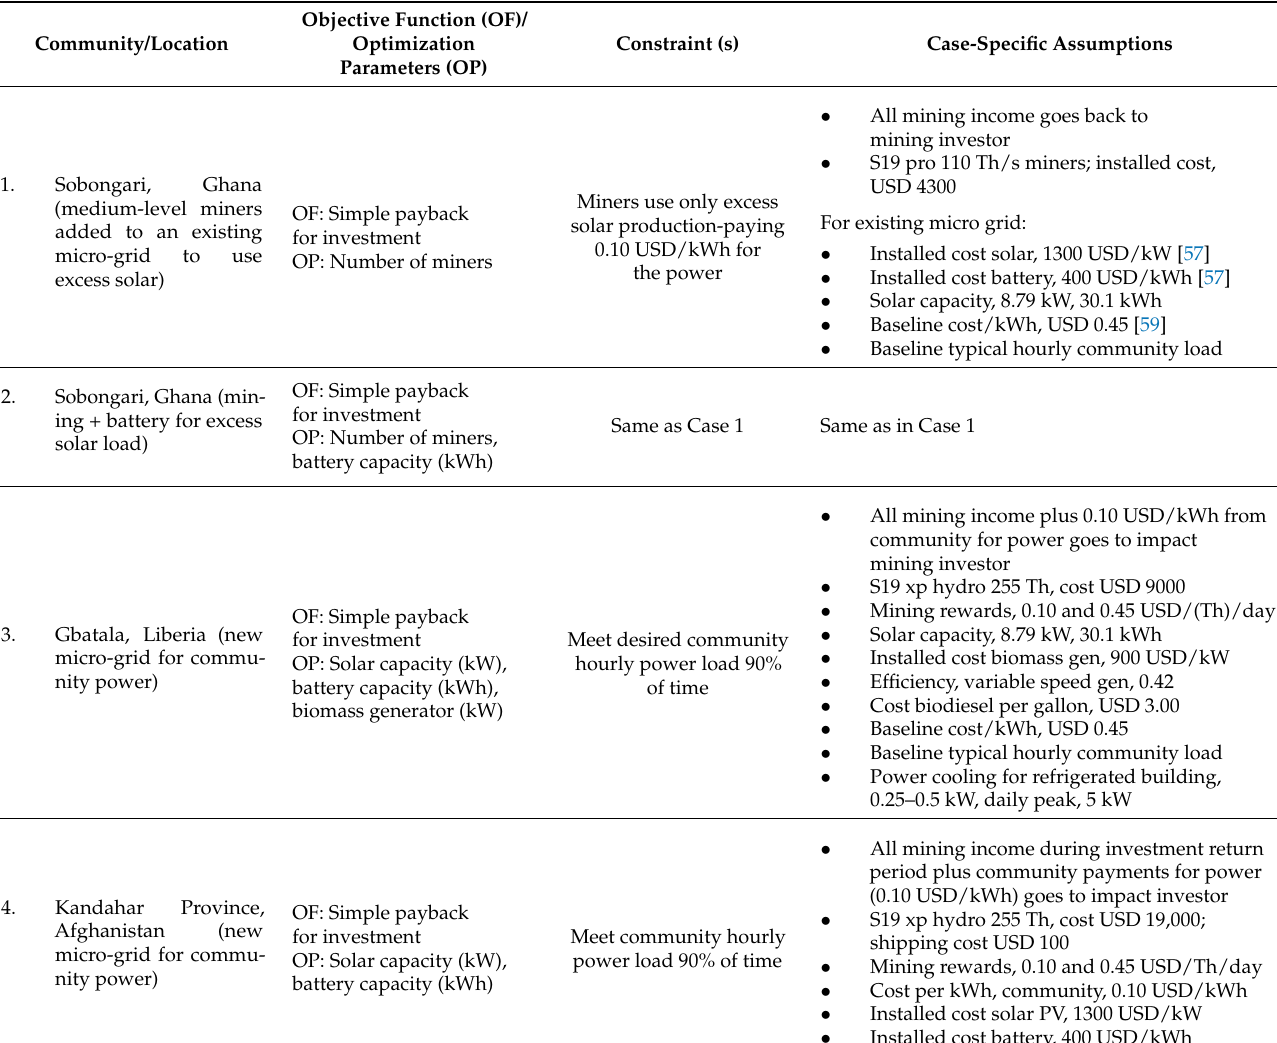
Table 2. Optimization parameters and